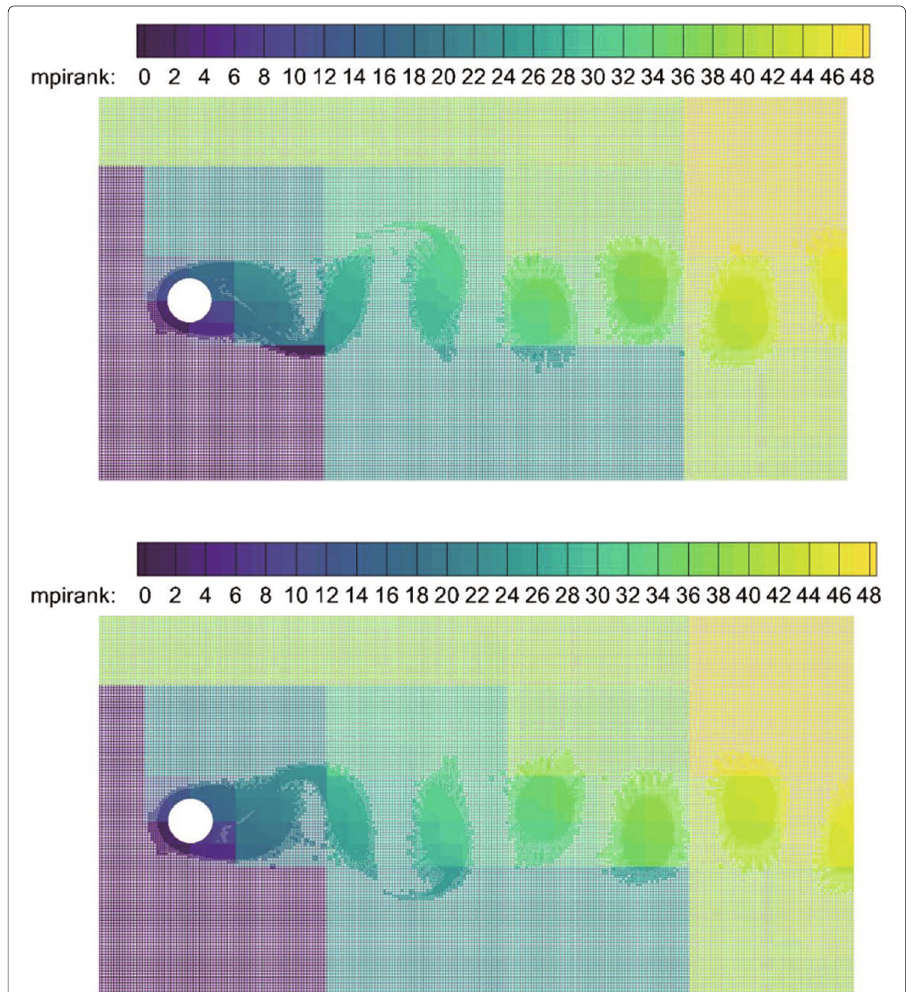
Fig. 19 The dynamic partition of adaptive grids at two different times on 48 cores